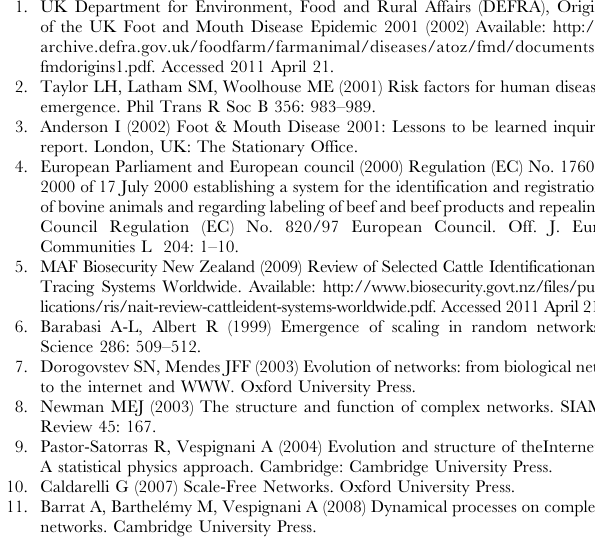
(TIFF) Figure S3 Time evolution of the global static features of networks on different timescales. The timeline of the number of nodes (top), the number of links (center), and the fraction of nodes in the giant component (bottom) are shown for daily, weekly, and monthly networks. Clear weekly and seasonal patterns are detected. (TIFF) Figure S4 Bovine activity. Panel A shows the probability distribution of the number of displacements that a bovine experiences during one year. Panel B displays the probability distributions of the distances covered during a single displacement. Since many links correspond to the displacement of very few animals, the same distribution is shown with different thresholds, i.e. considering only links with at least 2 or 10 bovines displaced during the year under study. This corresponds to keeping respectively 42% and 13% of the original links. Panel C shows the probability distribution of the distances covered by a single animal during its trajectory in one year. (TIFF) Figure S1 Size of the giant component of the network for increasing aggregation timescale D t . Average number Figure S5 Appearance of nodes by premises type. The of nodes (panel A) and relative fraction with respect to the system fraction of appearing links as a function of the weight w A size (panel B) of the giant component of networks aggregated on associated to the link. The black curve refers to the total fraction of time windows of length D t . As D t increases, the networks become appearing links, the red curves are obtained considering only the more globally connected. Sizes are averaged over all snapshots links pointing to a given premises type, the green curves are obtained with a given value of D t . obtained using only the links originating at a given premises type. The links’ behavior depends on the nature of the displacement, i.e. the premises type of origin/destination. Consistent results are Figure S2 Weight distributions for networks aggregated obtained for different timescales D t . The fraction of disappearing on different timescales D t . Red circles refer to the binned links (not shown) displays an almost identical behavior (similarly to distributions of the weight w A , measuring the number of animals ij the results presented in Figure 7 of the main text). moved along the link ij , whereas green squares refer to the binned distributions of the weight w B that counts the number of batches ij displaced along the link. The same representation of Figure 1 of the main text is adopted, with symbols representing the result of a particular snapshot, and grey lines the results obtained for a subset of the other snapshots. The cut-off of the w B distributions is ij naturally fixed by the choice of the aggregating period D t . The